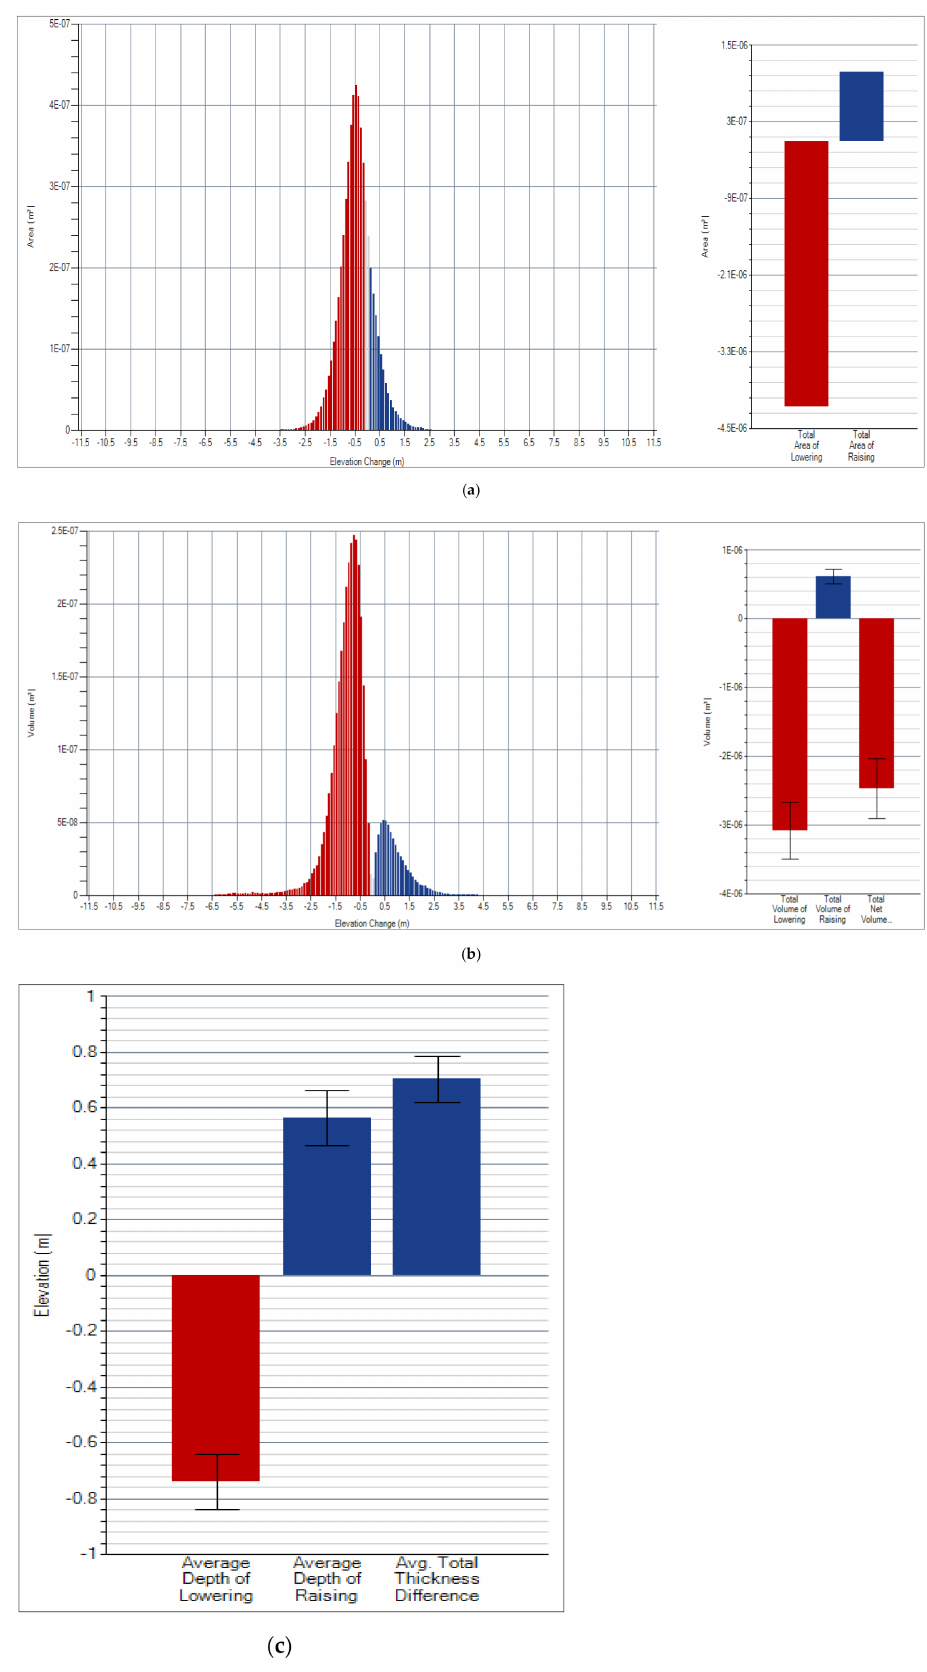
Figure A7. GCD result for ROI